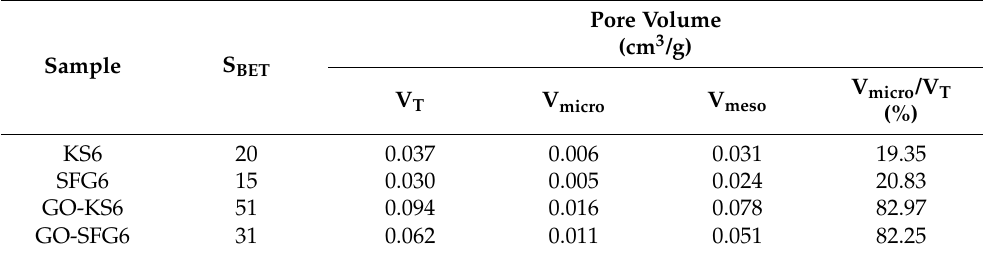
Table 2. The textural parameters of the graphite precursors and the prepared